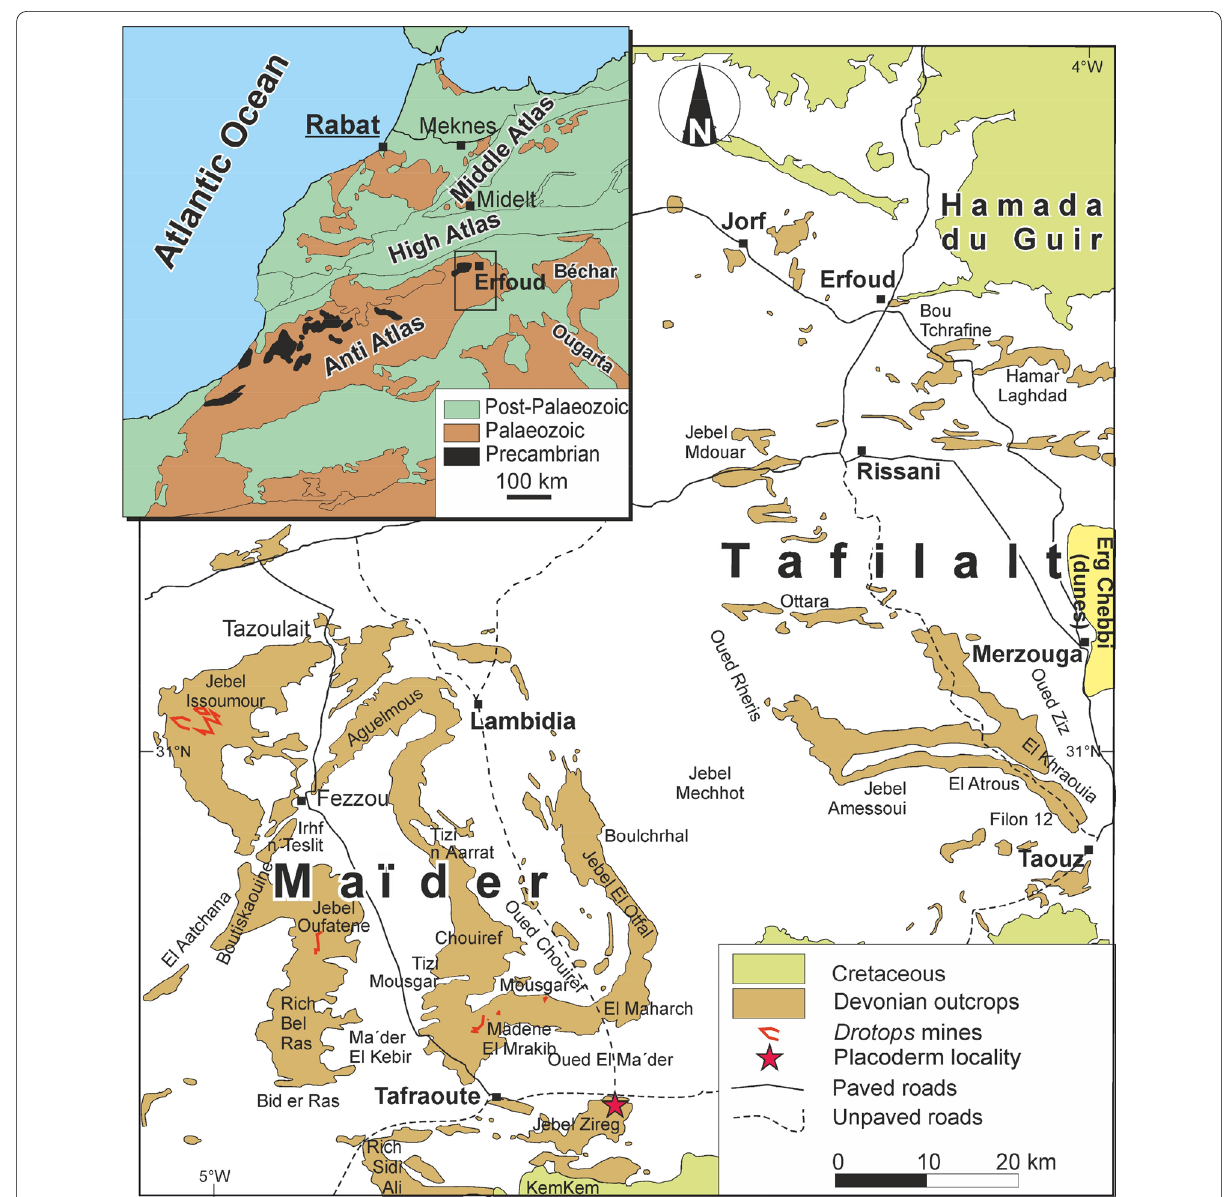
Fig. 1 Map of the Anti-Atlas of Morocco, showing where the Drotops layer crops out and Jebel Zireg, where the holotype of Leptodontichthys ziregensis gen. et sp. nov. was